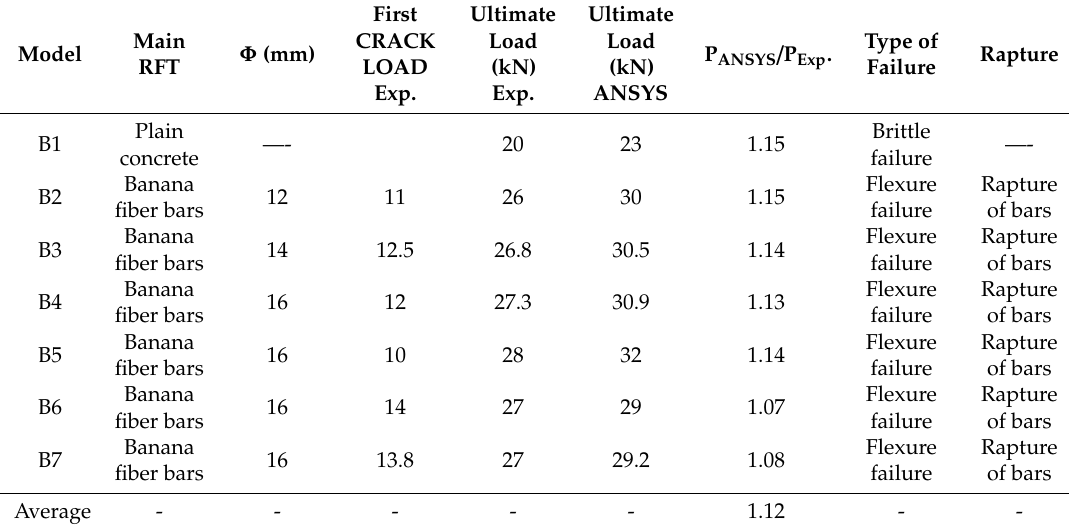
Table 6. Comparison between experimental and numerical results